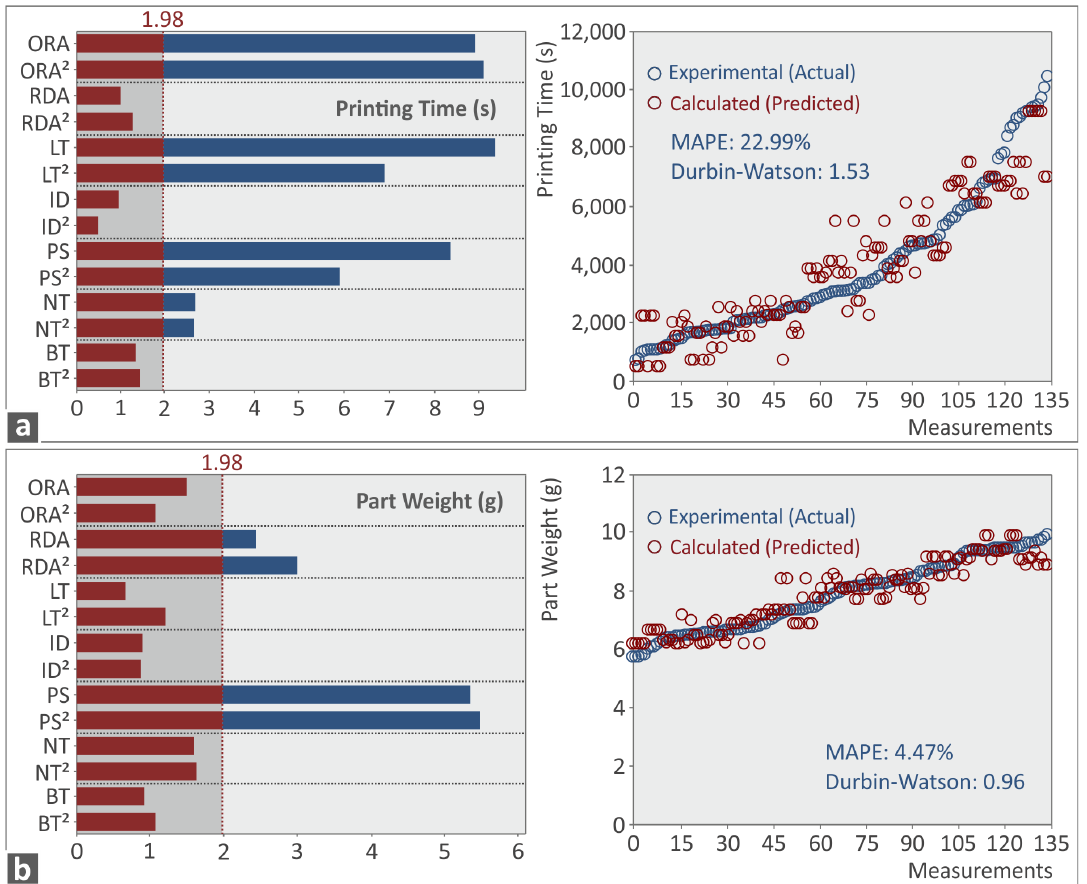
Figure 11. Pareto chart for ( a ) the printing time (s) and ( b ) the part weight (g). The statistically significant parameters are those crossing the threshold value of 1.98. On the right side, the experimental vs. the predicted values are presented.